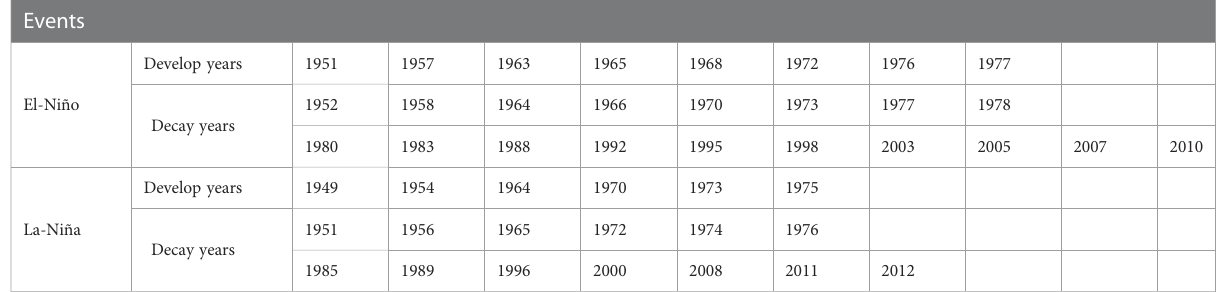
TABLE 2 Development and decay years of El-Niño and